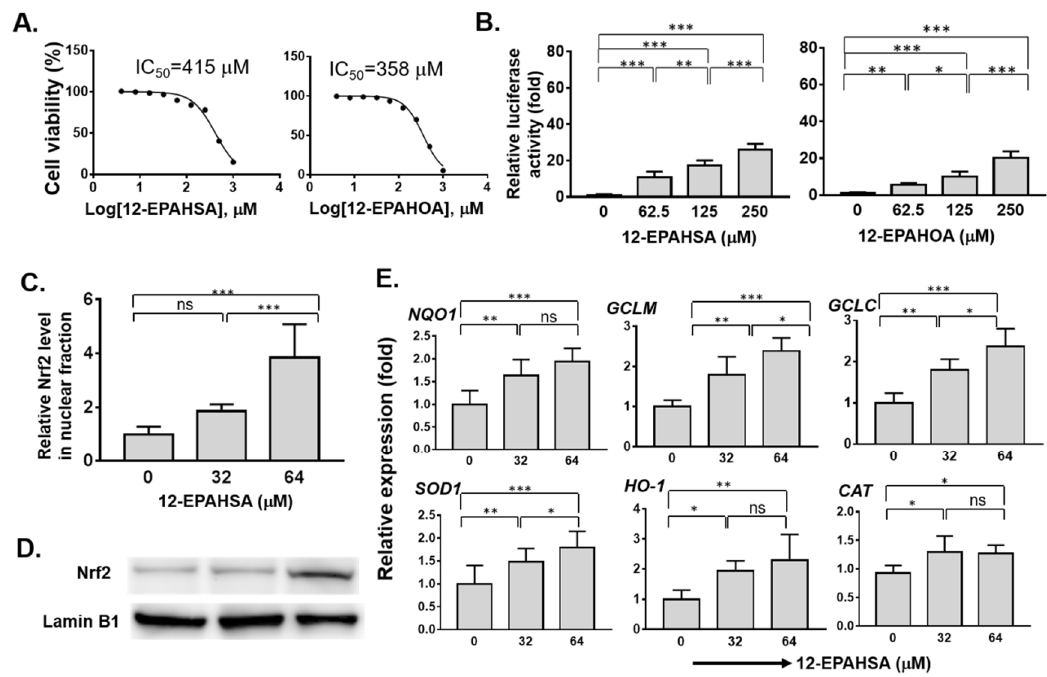
Figure 1. Evaluation of the antioxidant potential of eicosapentaenoic (EPA)-derived FAHFAs in C3A cells. ( A ) Cell viabilities (IC 50 ) of 12-EPAHSA and 12-EPAHOA ( B ) Reporter gene assay results of 12-EPAHSA and 12-EPAHOA ( C ) Relative nuclear Nrf2 protein expression induced by 12-EPAHSA ( D ) Protein levels of Nrf2 by Western blot analysis after treated with 12-EPAHSA. ( E) Relative expression of antioxidant enzymes in response to 12-EPAHSA treatment. * p < 0.05, ** p < 0.01, *** p < 0.001, ns: not significant (one-way ANOVA) ( n = 6). (NQO1: NAD(P)H quinone oxidoreductase 1, HO1: heme oxygenase-1, GCLM: glutamate–cysteine ligase modulatory subunit, GCLC: glutamate–cysteine ligase catalytic subunit, CAT: catalase, and SOD1: superoxide dismutase 1).